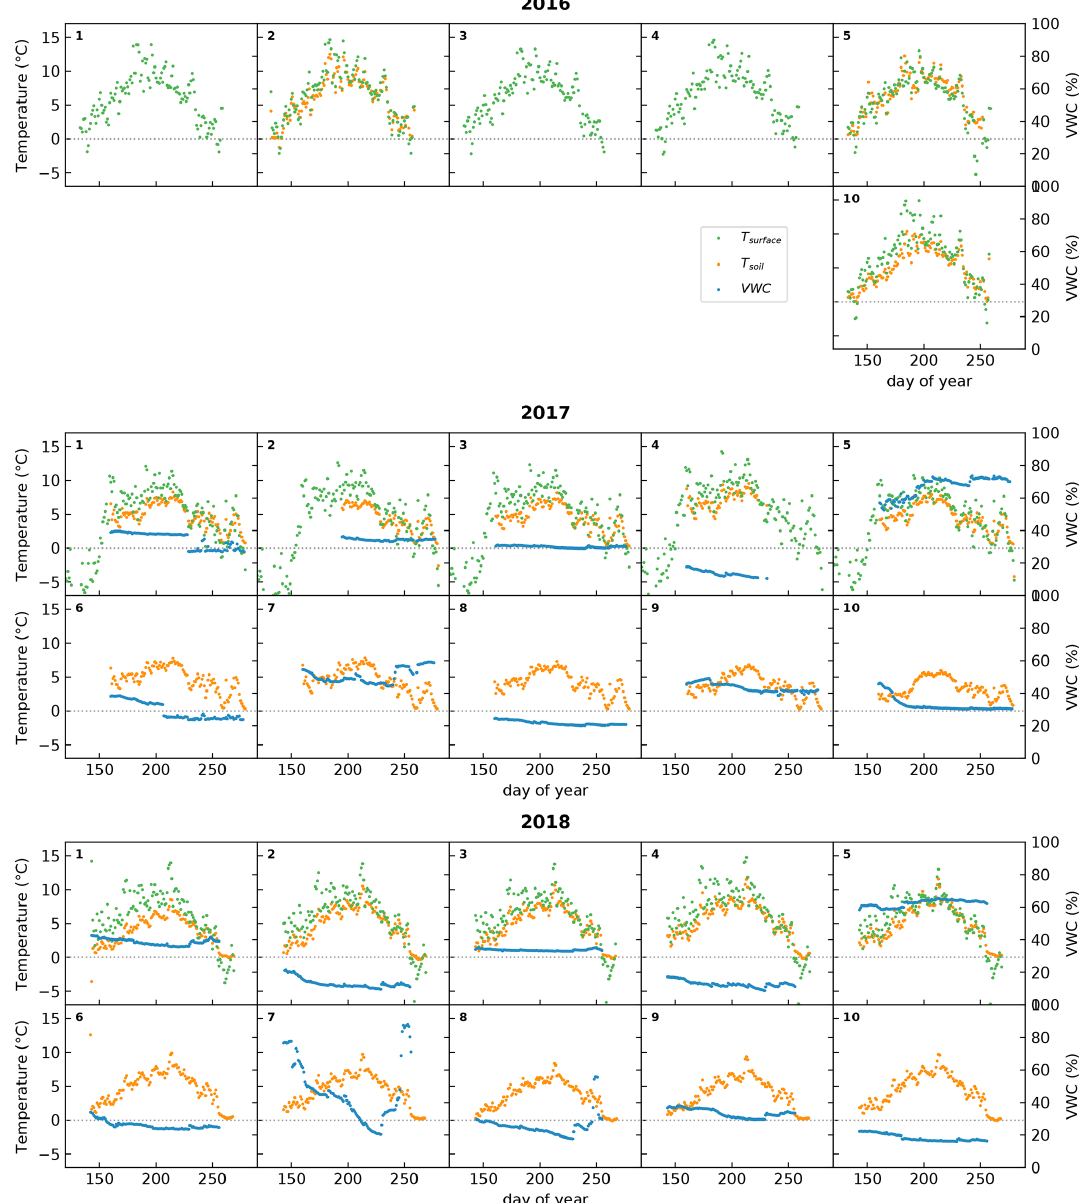
Figure 6. Time series of daily averages of surface temperature (green), derived from a TIR sensor, and in-situ-measured soil temperature (orange) and volumetric water content (VWC; in blue) at a depth of 10cm. The dotted line indicates 0 ◦ C. In 2016, the soil moisture sensors and some of the soil temperature sensors malfunctioned and are not plotted. Racks 6 to 9 had no additional sensors during 2016 and are not shown. The numbers in the top left corners of the subplots indicate the racks on which these sensors were